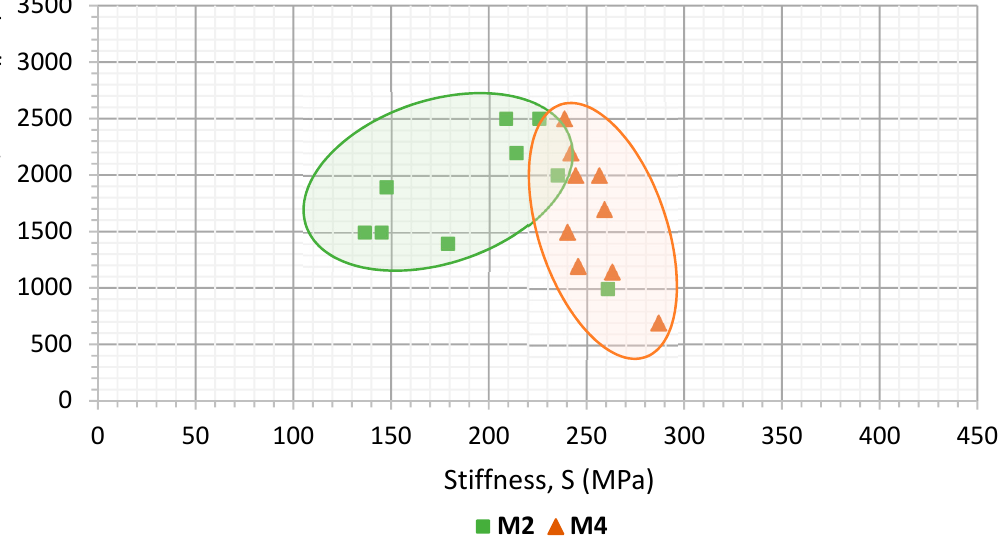
Figure 7. Results of stiffness and maximum deflection measured the mortars with CaCO 3 active filler. M2 conventional binder M4 modified binder.